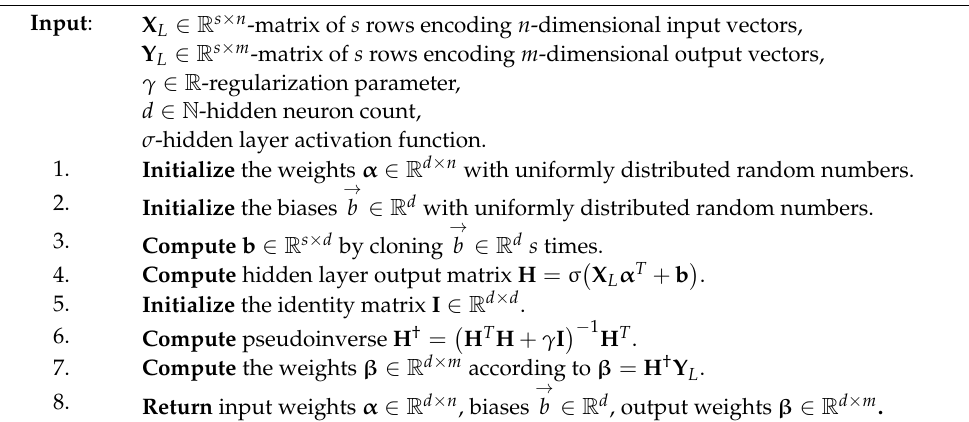
Algorithm 3 Extreme learning machine training.